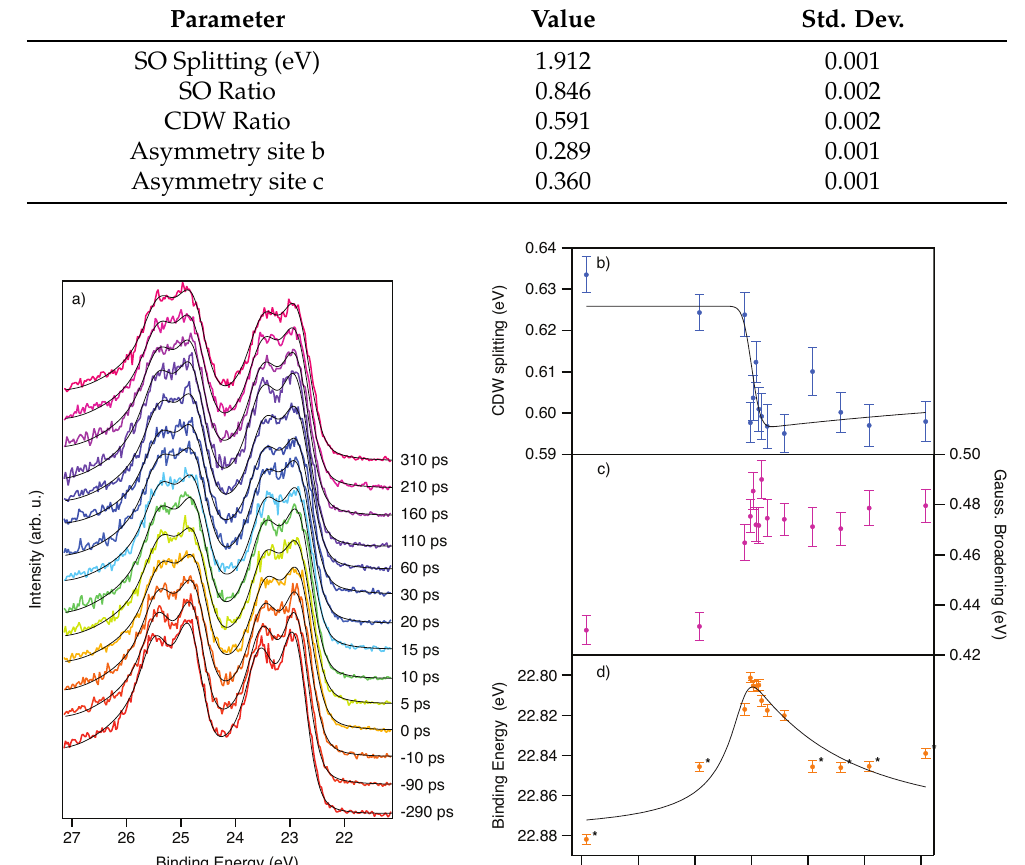
Table 1. Fitting results for the unpumped reference spectrum. Parameter